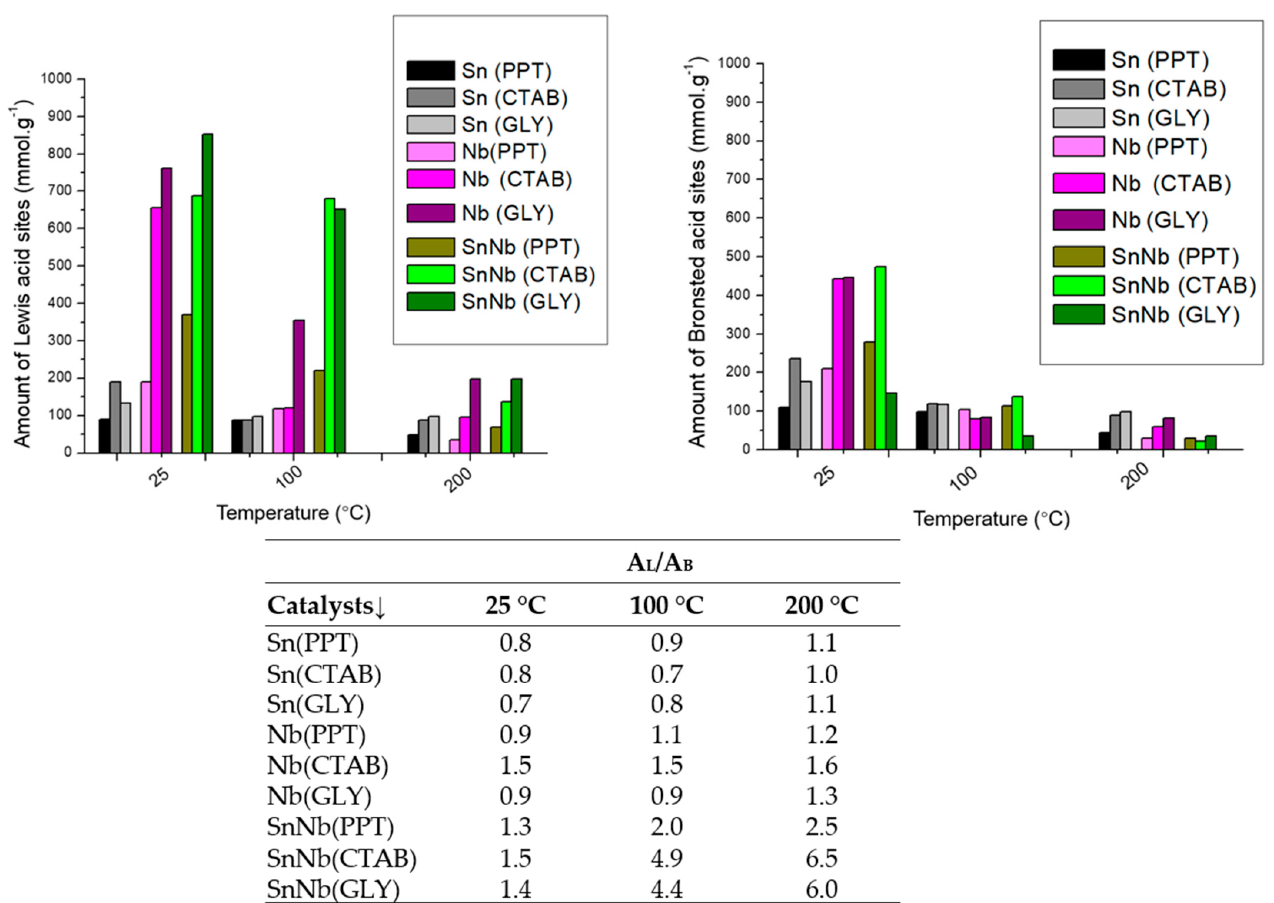
Figure 6. Amount of Lewis and Bronsted acid-sites and ratio of the number of Lewis and Bronsted acid-sites (A L /A B ) of the catalysts.